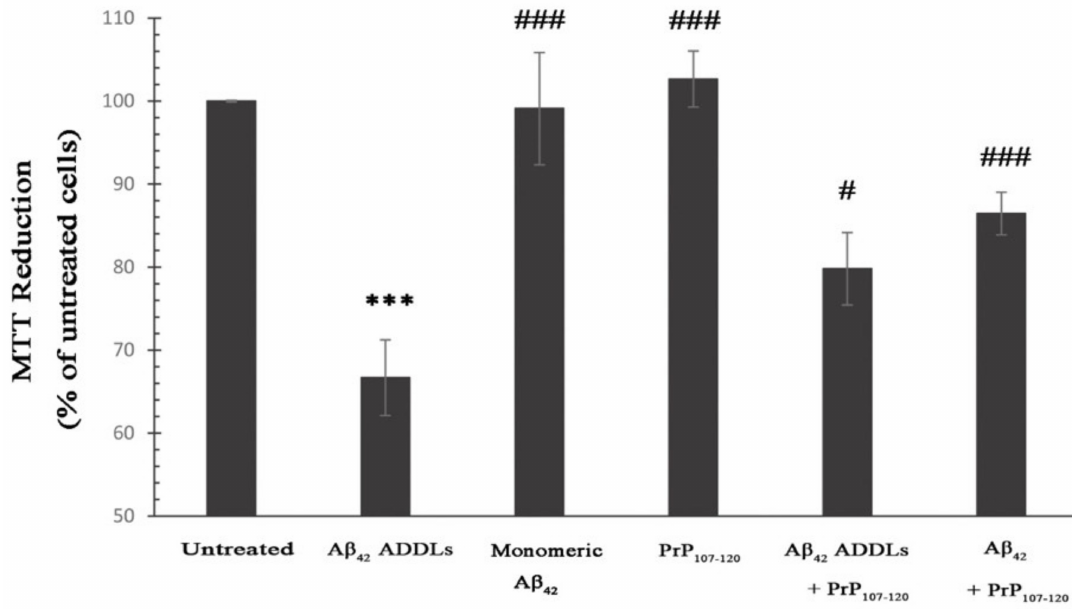
Figure 3. Cell viability assay in the presence of A β 42 oligomers and PrP 107–120 . 3-(4,5-dimethylthiazol- 2-yl)-2,5-diphenyltetrazolium bromide (MTT) reduction capacity of SH-SY5Y cells following 24